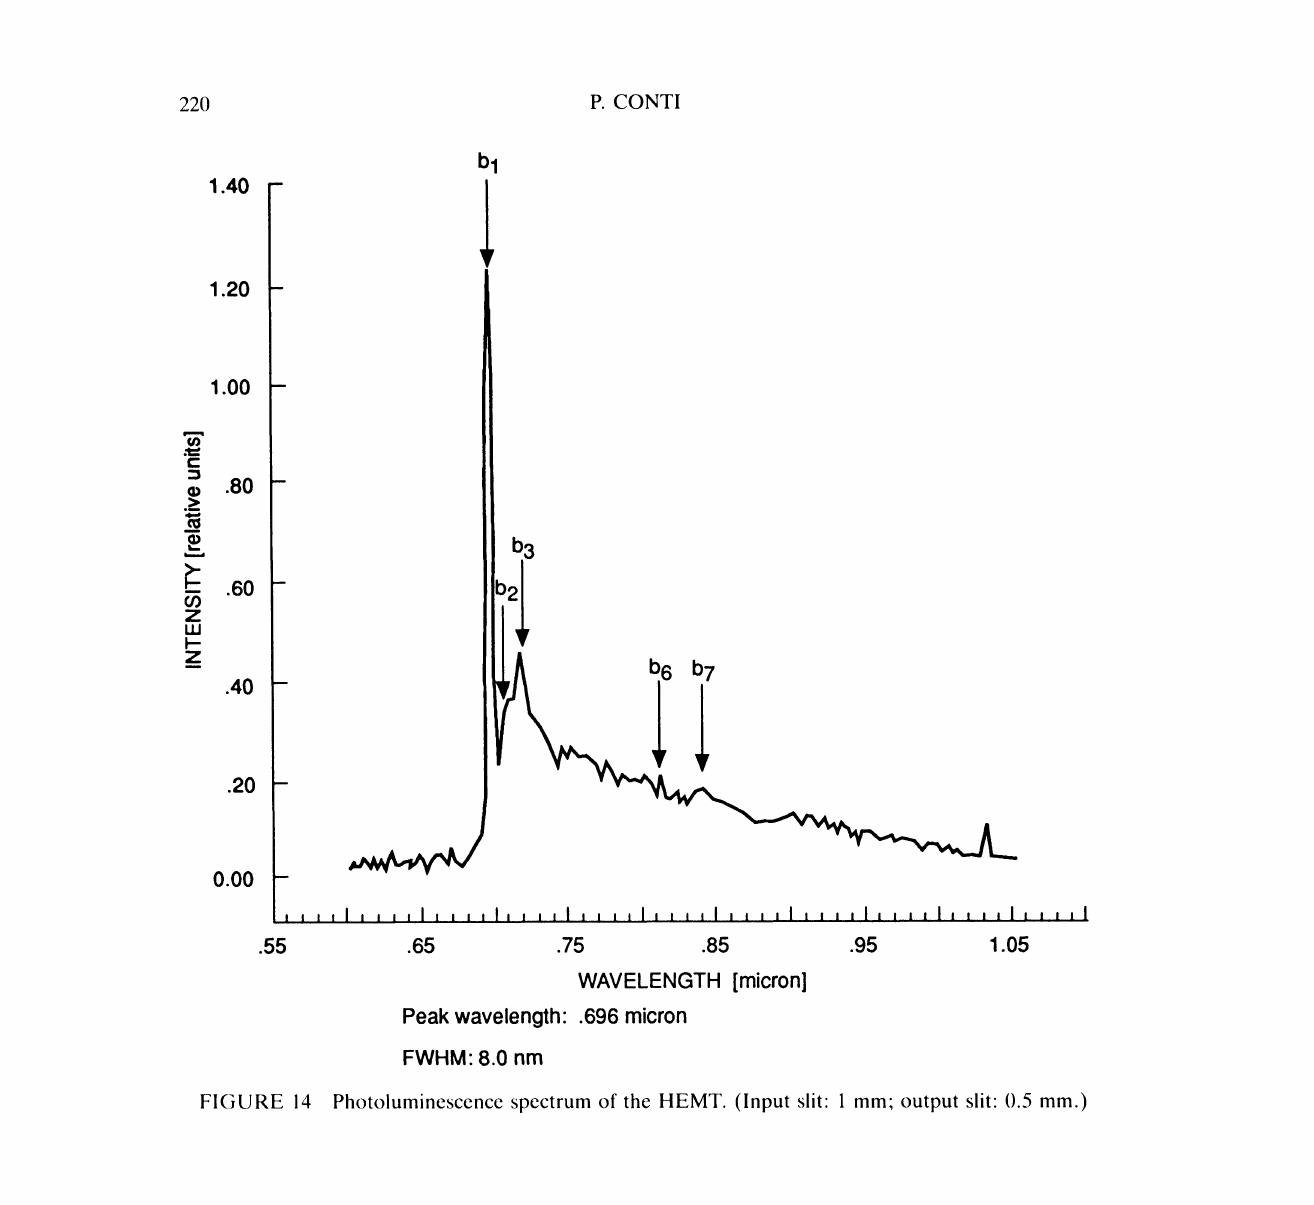
FIGURE 14 Photoluminescence spectrum of the HEMT. (Input slit" mm; output slit: 0.5